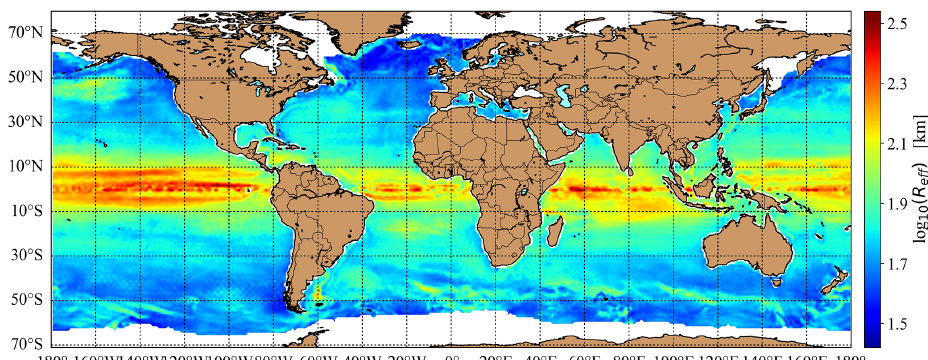
Figure 3. Geographic distribution of the effective radius R eff based on the estimate by Eq. (5) for the finest tiling of 1 . 25 ◦ × 1 . 25 ◦ . The color scale is logarithmic for better visualization. White pixels denote seasonally ice-covered regions.